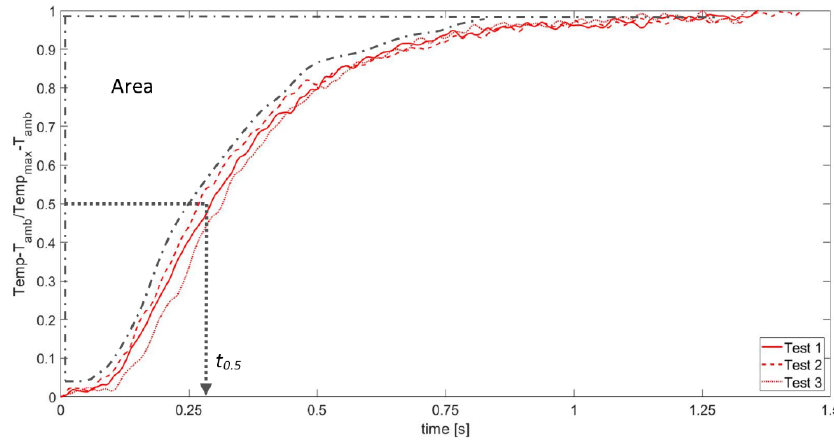
Figure 13. APS: normalized temperature rises and standard parameters [13,17].